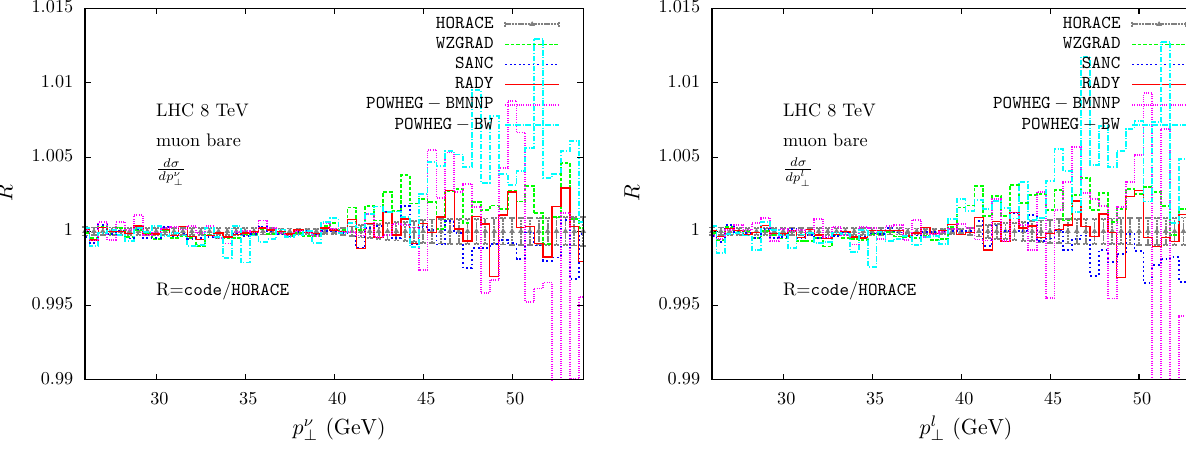
Fig. 2 Tuned comparison of the muon and muon neutrino transverse momentum distributions in pp → W + → μ + ν μ + X at the 8 TeV LHC with ATLAS/CMS cuts in the bare setup, including NLO EW corrections